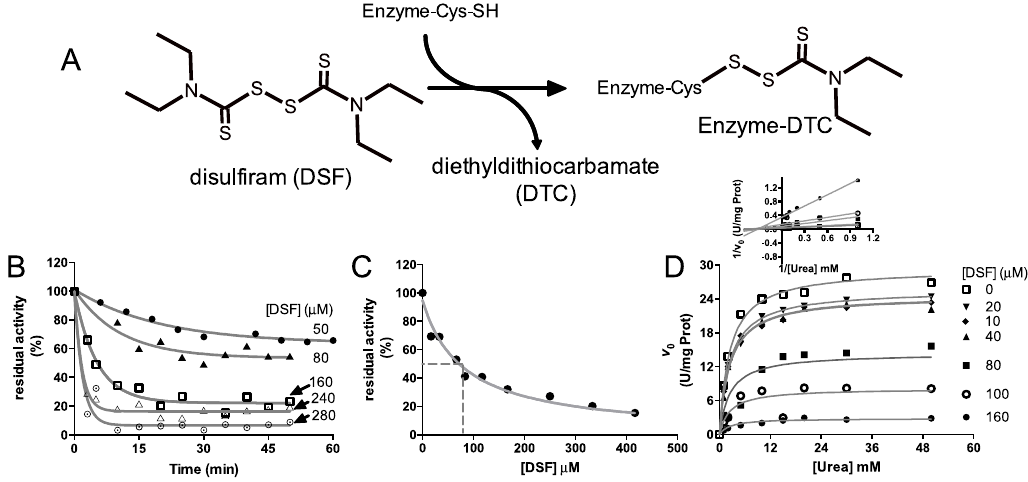
Figure 2. Kinetic characterization of the inhibition of CVU by disulfiram. ( A ) DSF general reaction of solvent-accessible Cys residues in enzymes. Susceptible Cys residues are carbamylated with a diethylthiocarbamate moiety (DTC) followed by the release of a proton together with the free DTC moiety. ( B ) Time courses of inactivation of CVU pre-incubed with different DSF concentrations at 37 ◦ C. Solid grey lines show the best curve fitting to a single exponential decay equation. Each curve is labelled with the DSF concentration used. ( C ) Inhibition kinetics of urease observed by the incubation with DSF. The solid grey line shows the best curve fitting to Equation (3). The dashed grey line shows the concentration of DSF at 50% of total inhibition. ( D ) Inhibition kinetic pattern obtained by measuring the saturation kinetics of CVU by urea at variable/fixed concentrations of DSF. The solid grey line shows the best curve fitting to Equation (5). The insert in D shows the Lineweaver–Burk plots of the kinetic pattern where intersection of linear curves to abscise axis is observed, consistent with a non-competitive inhibition. Here U is defined as the amount of enzyme that produces the change of one unit of the absorbance at 558 nm per milligram of protein. Non-linear and linear curve fitting and plots were prepared using Graph Pad Prism 5 ® . The presented experiments are one of three typical results. Chemical structures were drawn using ACD/ChemSketch ® (Advanced Chemistry Development, Inc., Toronto, ON, Canada).